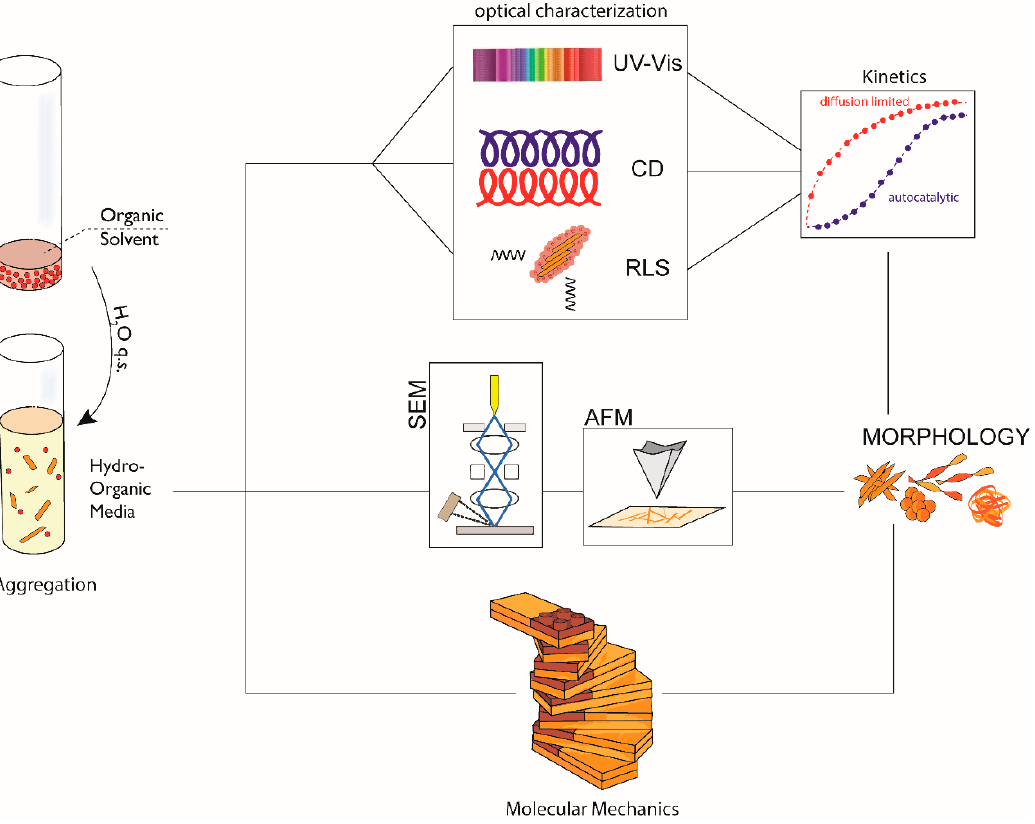
Figure 1. Schematic cartoon illustrative of our general approach for the aggregation studies.